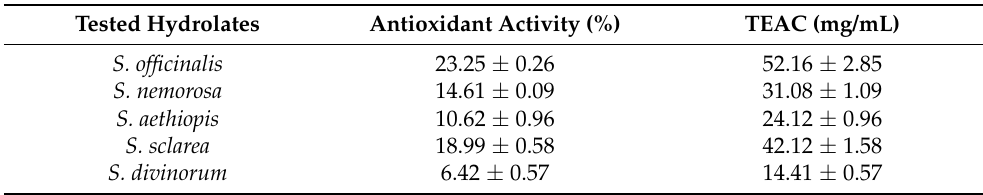
Table 3. Antioxidant activity expressed as percentage inhibition of DPPH radical at a concentration of 100 µ g/mL of the tested hydrolates. Tested